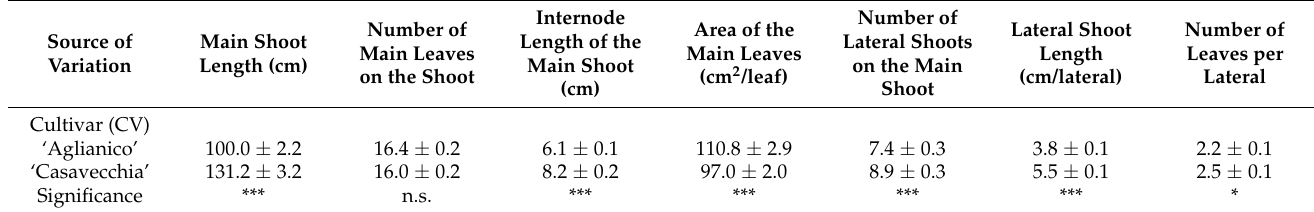
Table 1. Difference between ‘Aglianico’ and ‘Casavecchia’ vines in shoot vegetative characteristics measured at the phenological stage H, pre-anthesis (just before the application of the experimental treatments). N.s., *, and ***: Not significant, or significant at p ≤ 0.05, and 0.001, respectively.